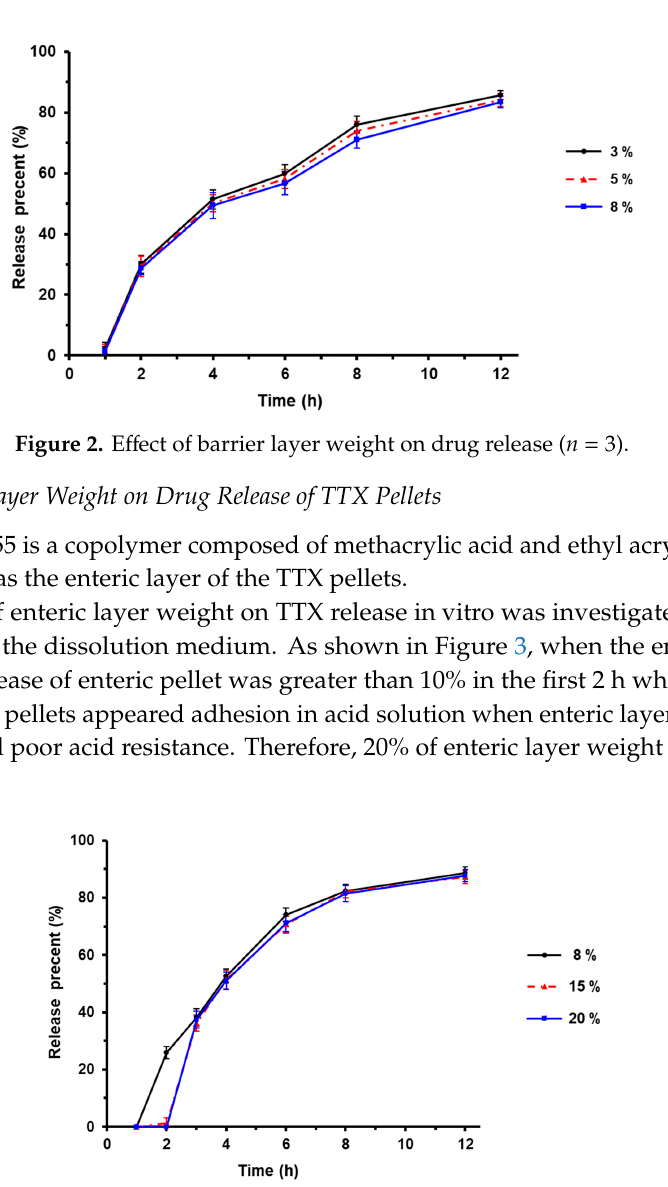
Figure 3. Effect of enteric layer weight on drug release ( n = 3).